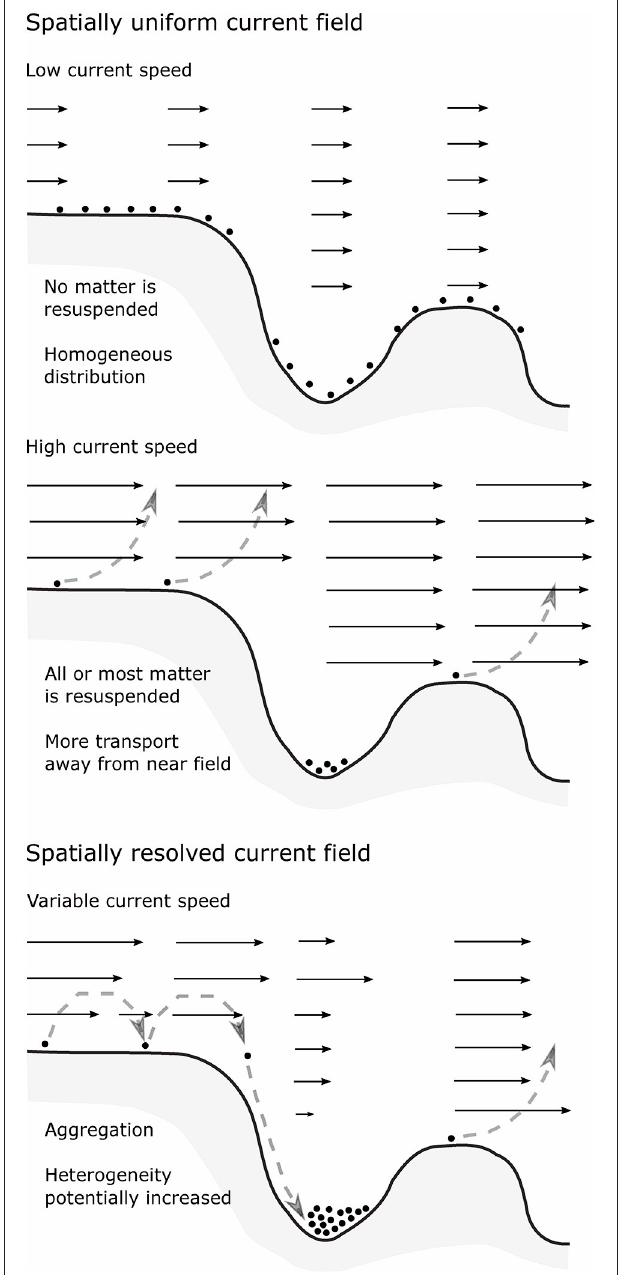
FIGURE 11 | Conceptual illustration of how increased spatiotemporal resolution of the water current fields lead to changes in the simulated transport of particulate organic matter. If resuspension processes are included, a uniform water field may lead to consistent over or under estimation of the concentration of organic matter depending on the current speed. A high resolution variable current field may lead to resuspension in some places and aggregation of matter in